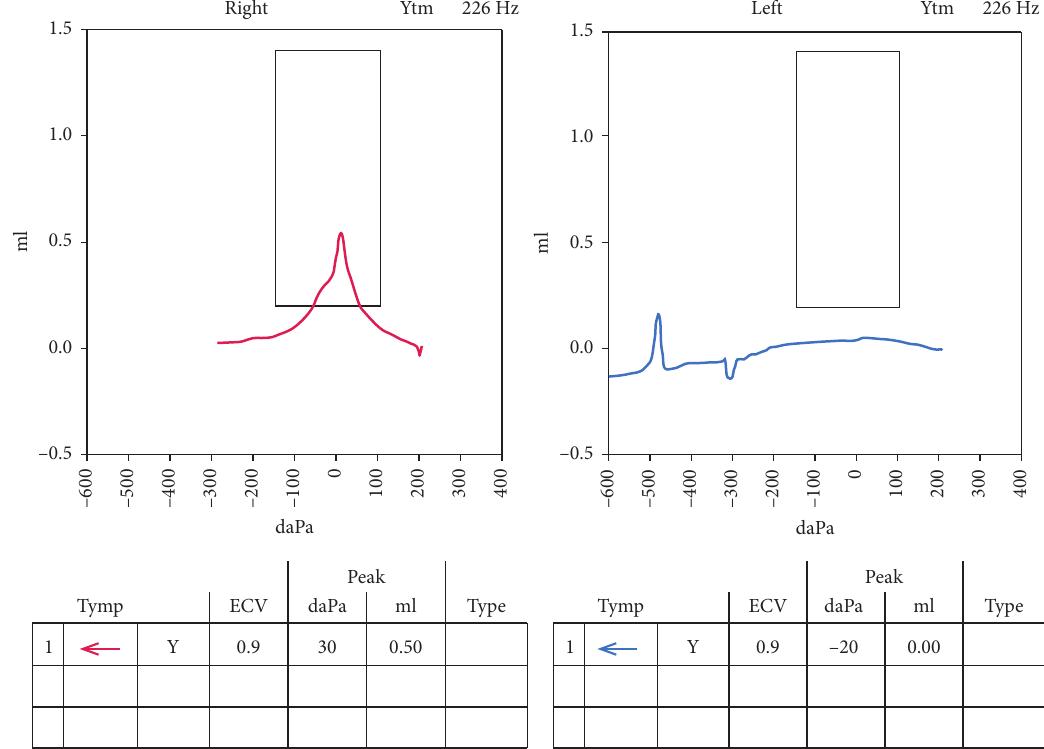
Figure 2: Tympanogram showing type A for the right ear and type B for the left